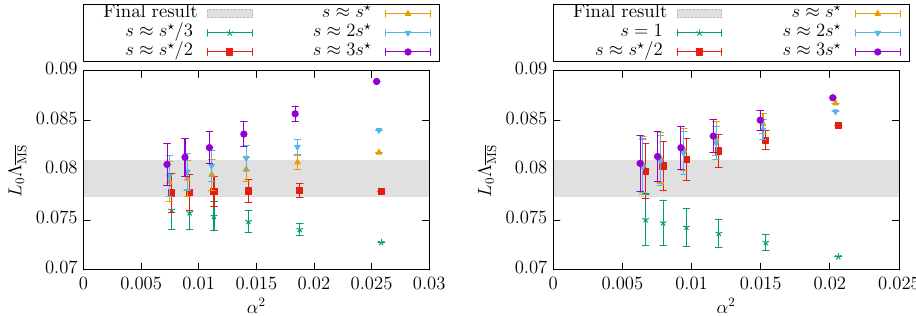
Fig. 5 Determination of L 0 (cid:2) at different physical scales (parametrized by the value of α in the x -axes), and using different renormalization MS scales (value of s ) to match with the MS scheme. The left (right) panel uses the SF ν -scheme with ν = 0 ( ν = − 0 . 5), cf. text